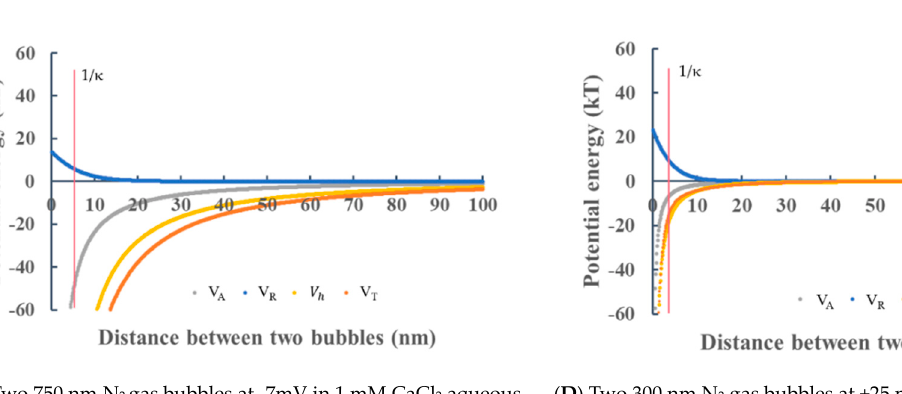
Figure 11. Total potential energy V T depending on the distance between two nanobubbles in the salt aqueous solution. ( A ) Two 230. nm N 2 nanobubbles at − 10mV in 1 mM CaCl 2 aqueous solution on the prepared day, ( B ) Two 170 nm Ar + 8%H 2 nanobubbles at +16 mV in AlCl 3 aqueous solution on the prepared day, ( C ) Two 750 nm N 2 gas bubbles at -7mV in 1 mM CaCl 2 aqueous solution at 3rd day, ( D ) Two 300 nm N 2 nanobubbles at +25 mV in 1 mM AlCl 3 aqueous solution after 3 days.